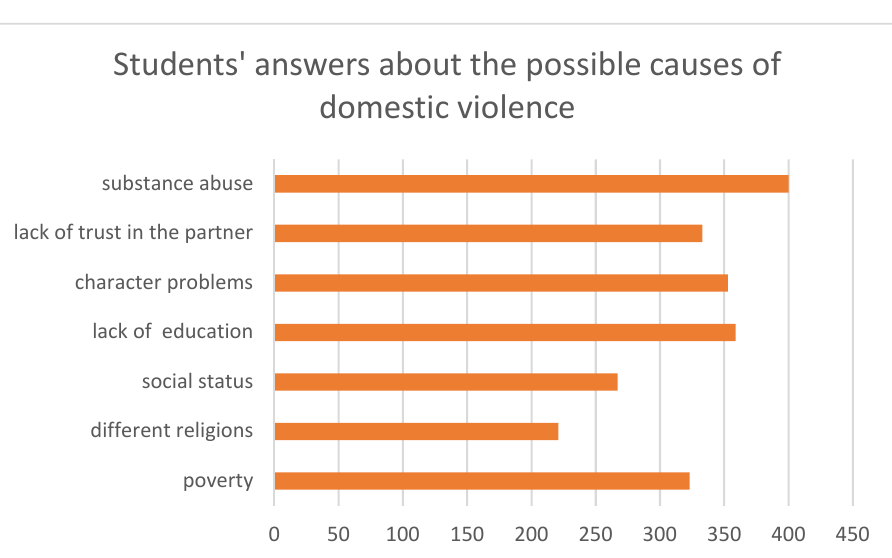
Figure 1. Students’ answers about the possible causes of domestic violence.